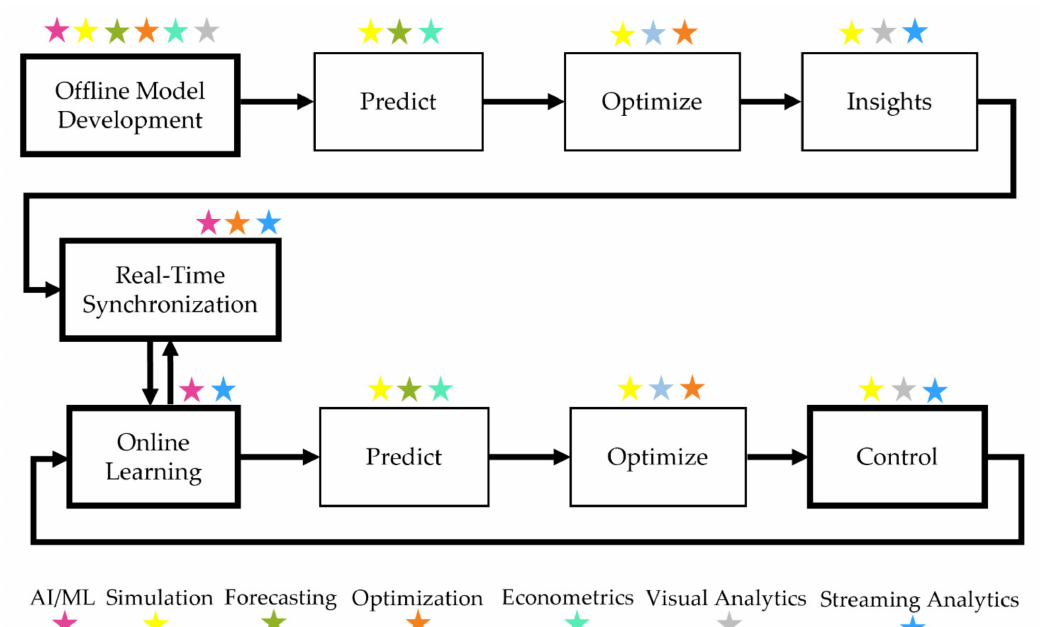
Figure 5. Key factory digital twin functions and enabling